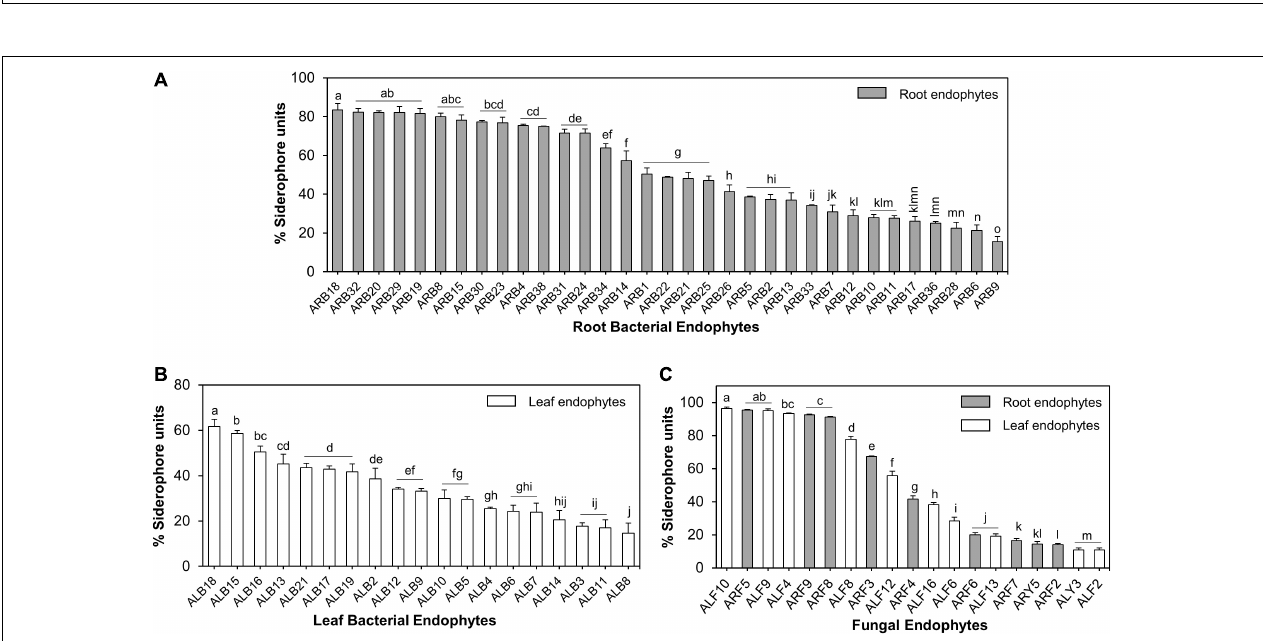
FIGURE 7 | Siderophore production by microbial endophytes of A. euchr oma estimated using liquid CAS assay. Siderophore production by root (A) and leaf (B) associated bacterial endophytes. (C) Siderophore production by root (gray bars) and leaf (white bars) associated fungal endophytes. Different alphabets indicate a significant difference ( p ≤ 0.05) as calculated using Duncan’s multiple-range test. Error bars represent standard deviation ( n = 3).